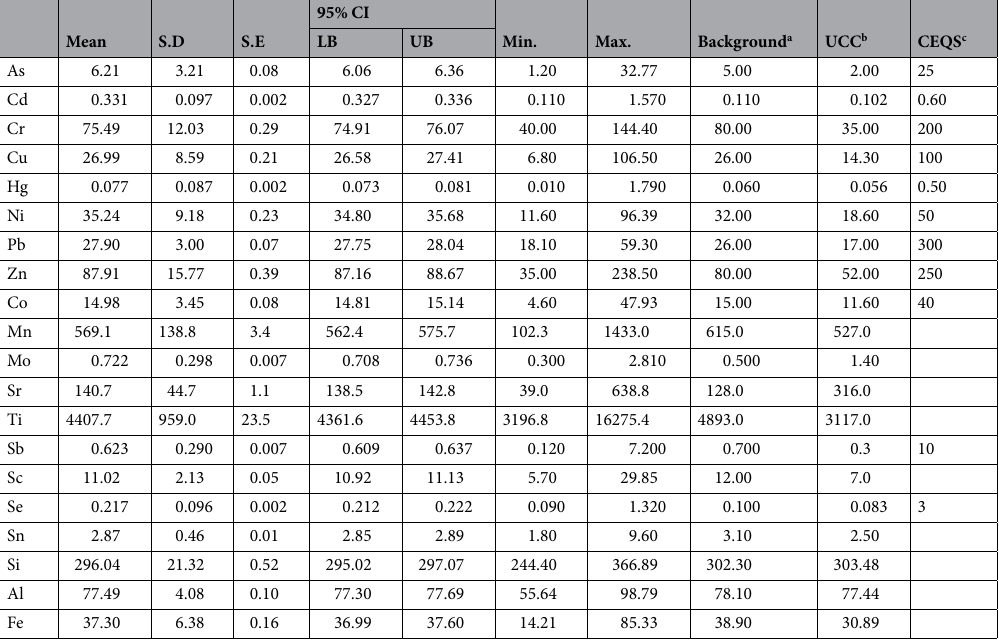
Table 2. Total averages of soil metals and comparisons with background values, element contents in the upper continent crust, and well as China’s standards (unit in mg/kg). a-Chongqing background values. b-upper continent crust. c-Chinese environmental quality standard for soils (grade II: 6.5 < pH < 7.5; GB15618–1995) (CEPA